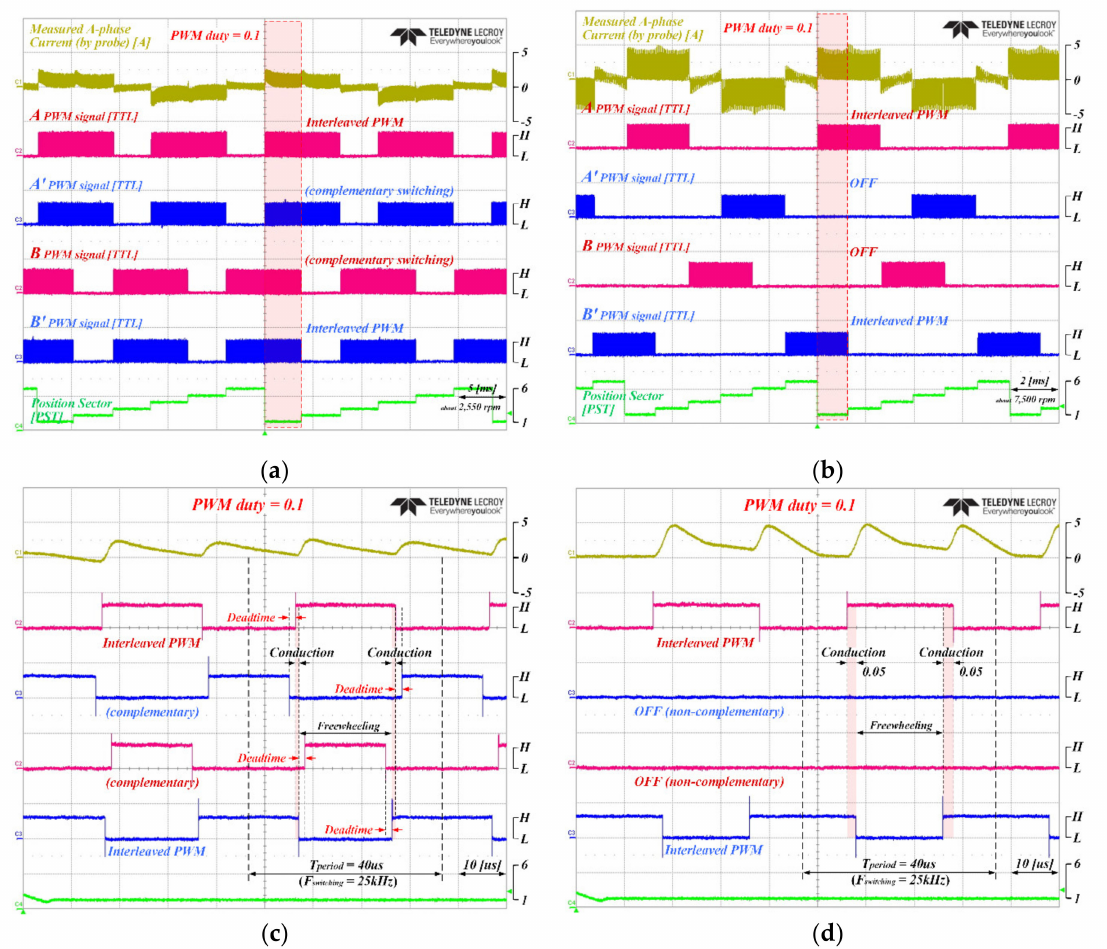
Figure 7. PWM pattern of the H-PWM-L-PWM method according to position sector: ( a ) complementary switching mode; ( b ) non-complementary switching mode; ( c ) enlarged waveform in Position Sector 1 of Figure 7a; and ( d ) enlarged waveform in Position Sector 1 of Figure